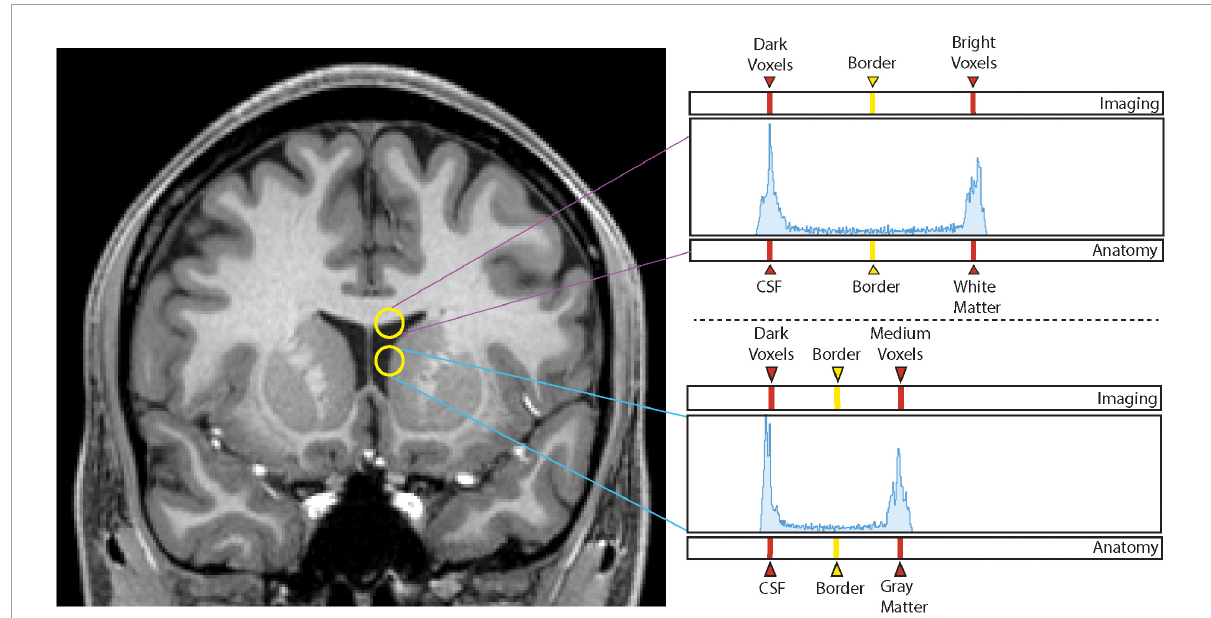
FIGURE1 Histogram method. Sampling of voxel intensities between white matter and cerebrospinal fluid (upper yellow circle) produces a histogram (upper right panel) in which the left peak corresponds to dark voxels associated with cerebrospinal fluid (CSF) and the right peak corresponds to intense voxels of white matter. The vertical line equidistant between the two peaks represents the interpeak distance that produces the designated border between the two peaks, and thus, the two brain tissues. Sampling of voxel intensities using the lower circle produces the lower right histogram in which the left peak again corresponds to dark voxels of the CSF space, and the right peak to medium intensity voxels of the gray matter of the caudate nucleus. Notice there is now a different interpeak distance and a different border between these two